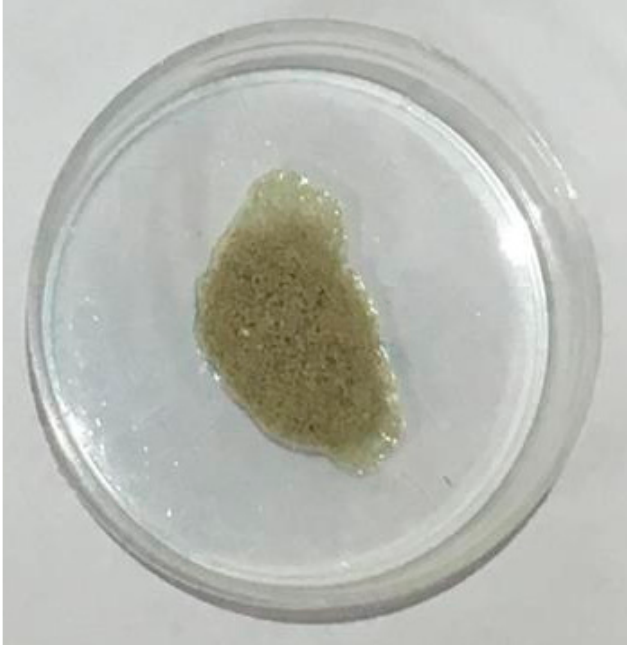
Figure 1. Photograph of the PVC/attractant (food) dispenser used in this study.